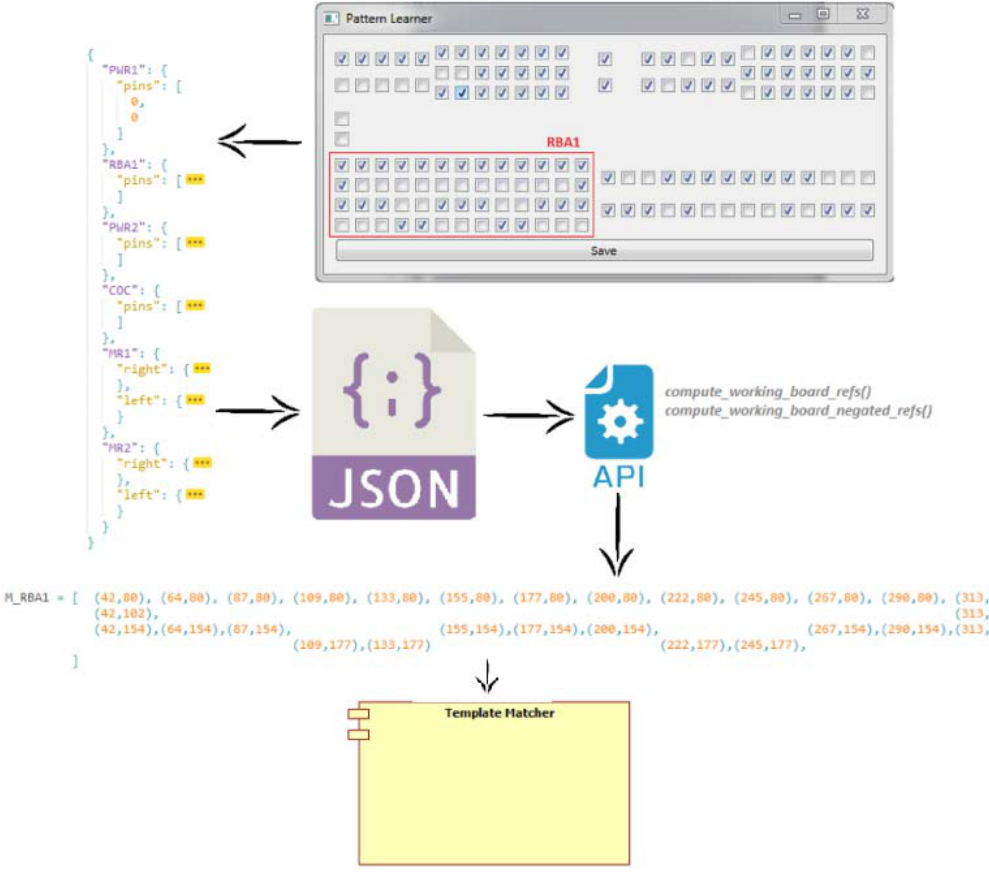
Figure 15. Coordinates conversion process.